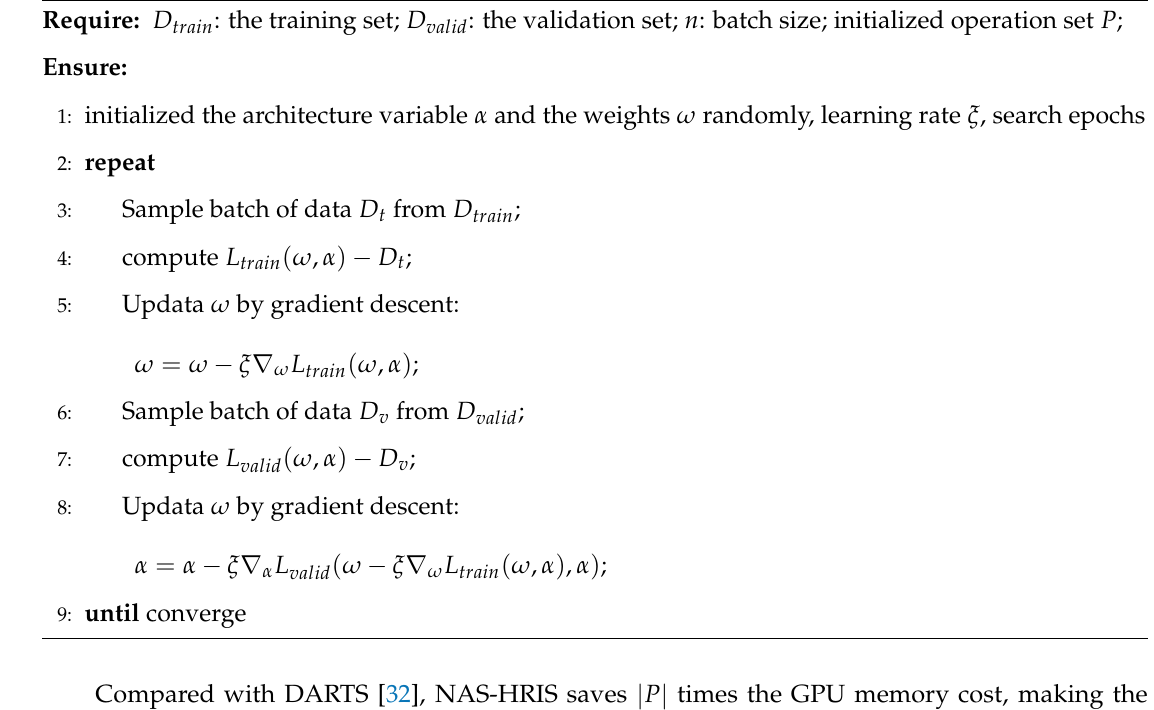
Algorithm 1 NAS-HRIS Search Encoder for High-Resolution Remote Sensing Image